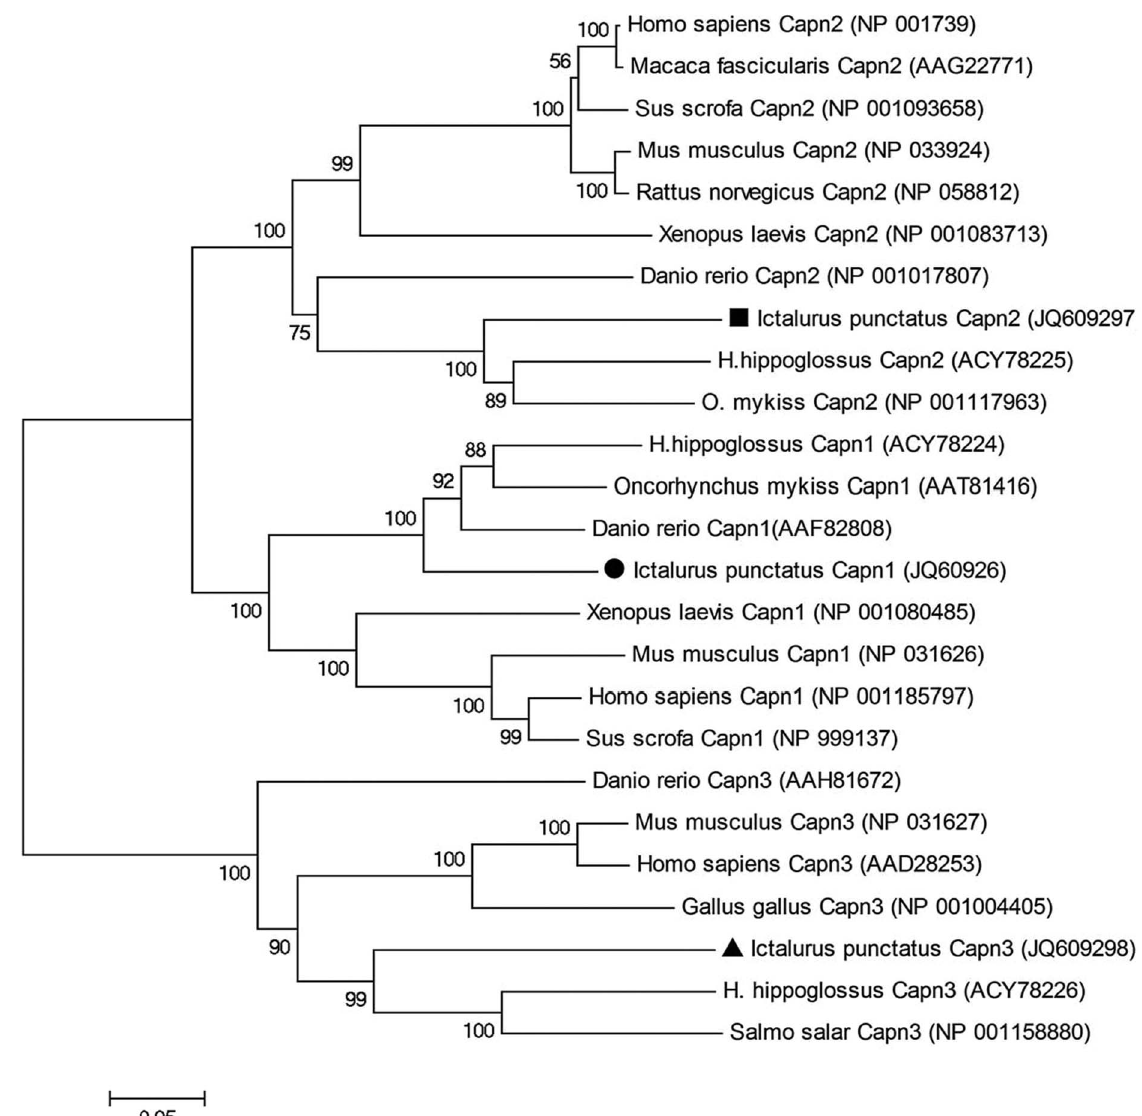
Figure 3. Phylogenetic tree comparing the amino acid sequences of Clpn1, Clpn2, and Clpn3 in catfish with those of other vertebrate species. GenBank accession numbers of each sequence used in the analysis are indicated on the right side of the species name. The phylogenetic tree is generated based on ClustalW generated multiple sequence alignment using the neighbor-joining method which ignores gaps as implemented in MEGA 4.0. The topological stability of the neighbor tree was evaluated by 10,000 bootstrapping replications, and the bootstrapping percentage values are indicated by the numbers at the tree nodes.